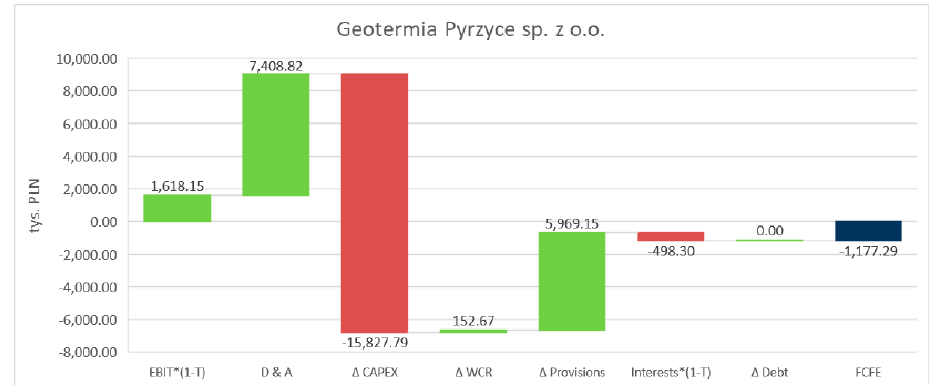
Figure 12. FCFF cash flows generated by Geotermia Mazowiecka S.A. in 2016–2019. Source: Own study on the basis of: [53].